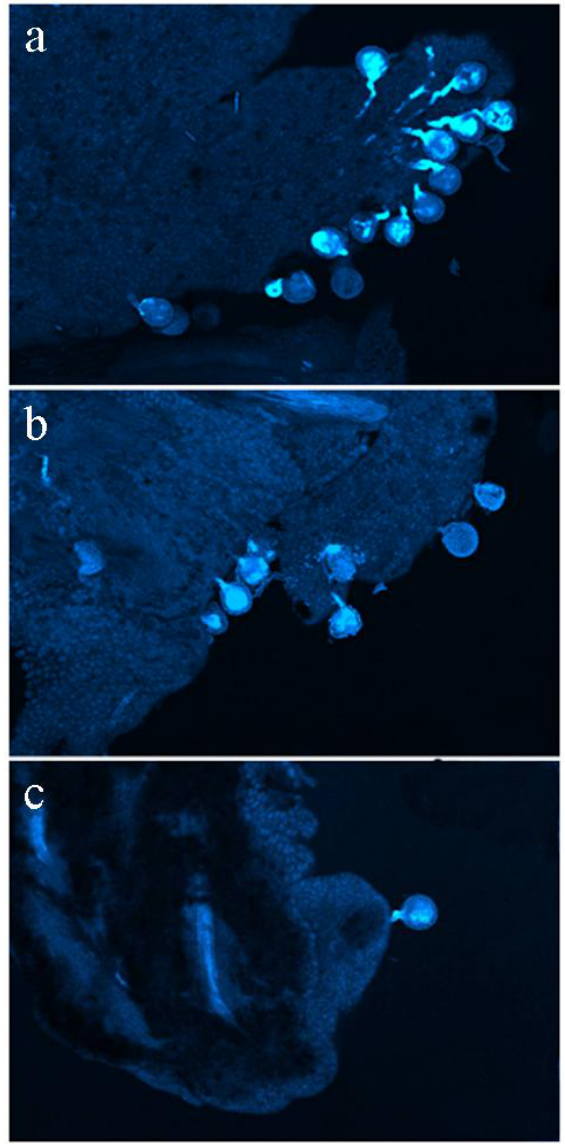
Pollen germination on the stigma of early blooming perfect flower (a), pistillate flower (b), and perfect flower at the bud stage (c). Scale bar is 100